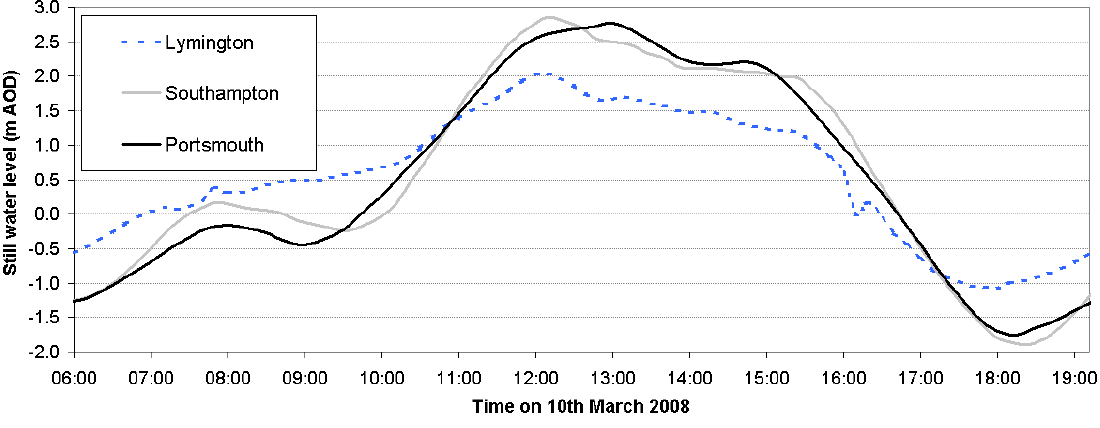
Figure 3. Water level time-series recorded during a storm surge event on the 10th March 2008.